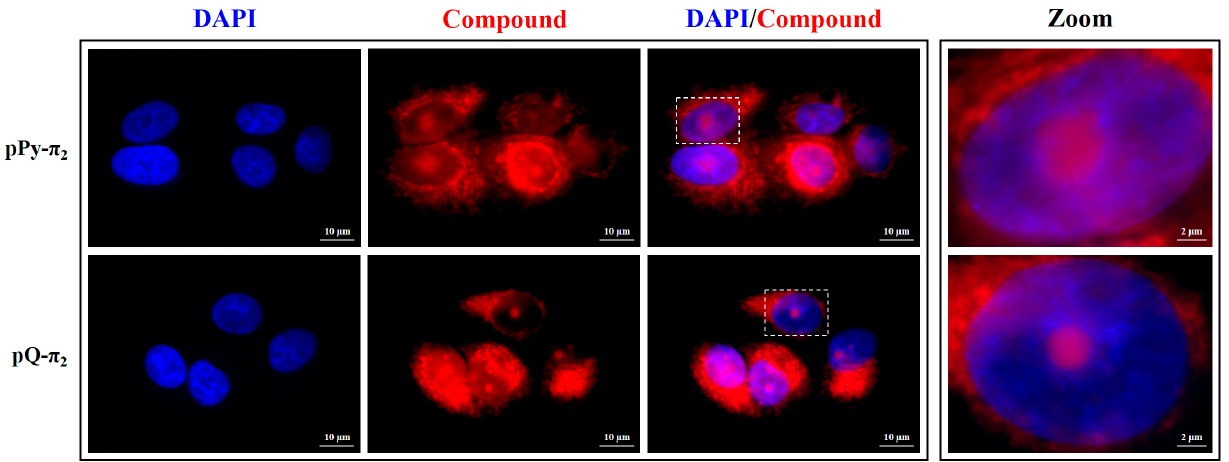
Figure 6. Left : representative fluorescence microscopy images of fixed A549 cells stained with DAPI (blue, DAPI filter), 10 µ M pPy- π 2 and pQ- π 2 compounds (red, TRITC filter), and the relative merged images. Image magnification: 60 × . Right : zoom-in of representative cells.